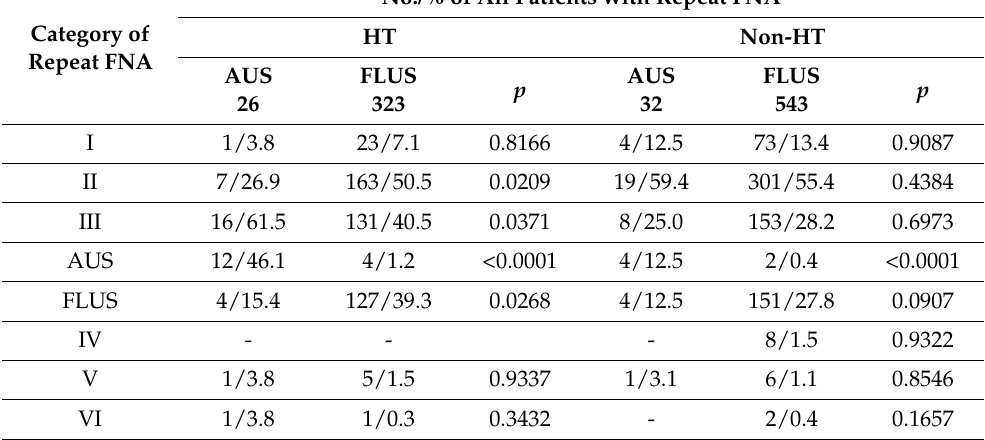
Table 4. Results of repeat FNA in patients of HT and non-HT groups for AUS and FLUS nod- ules